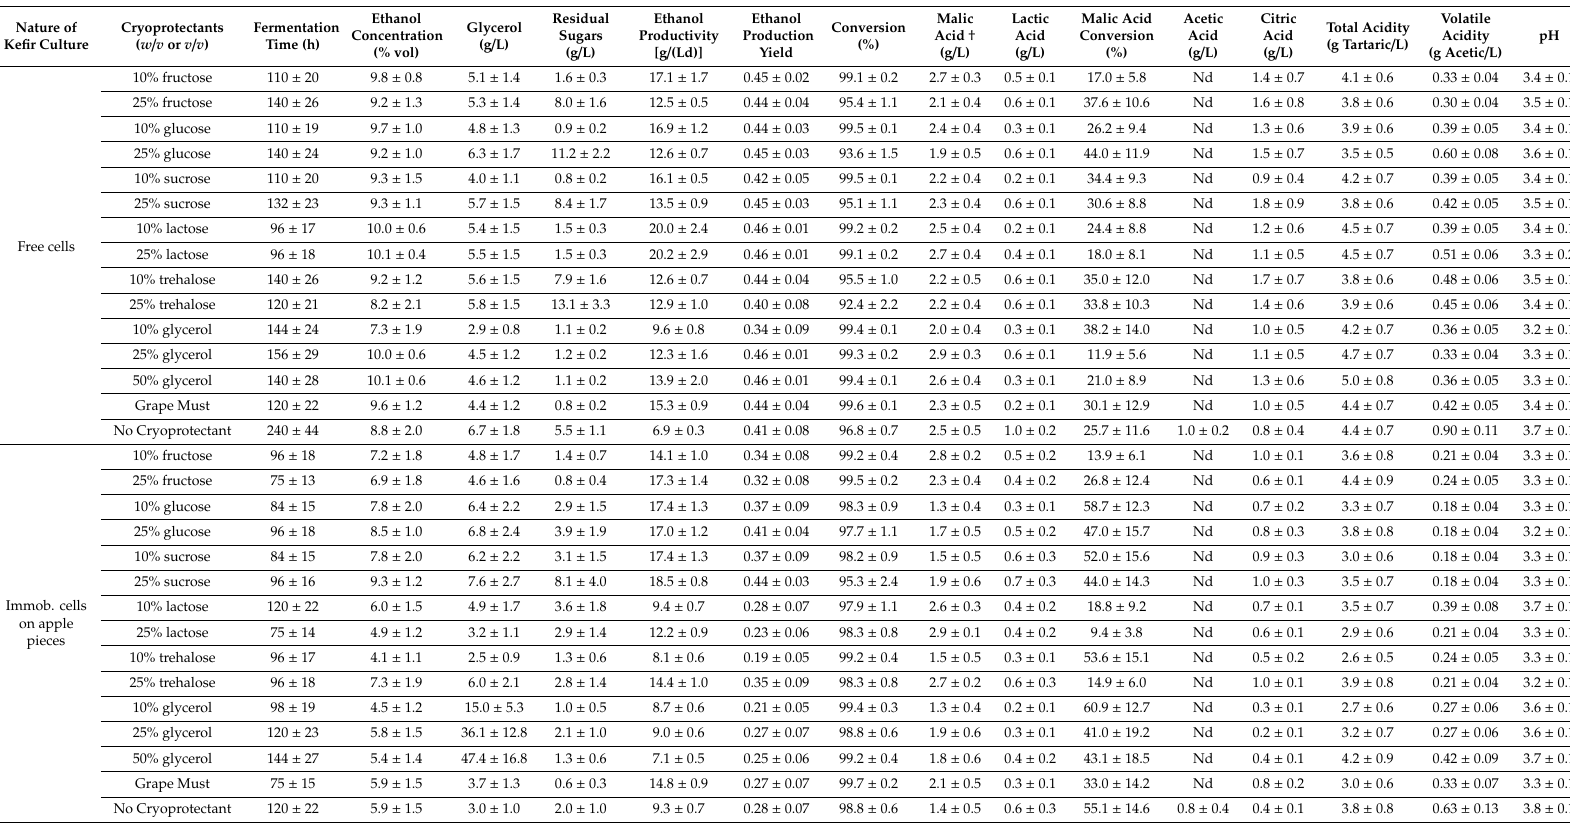
Table 1. Fermentation parameters and organic acids profile of low alcohol wines produced using freeze-dried free or immobilized kefir culture at 30 ◦ C. Natureof